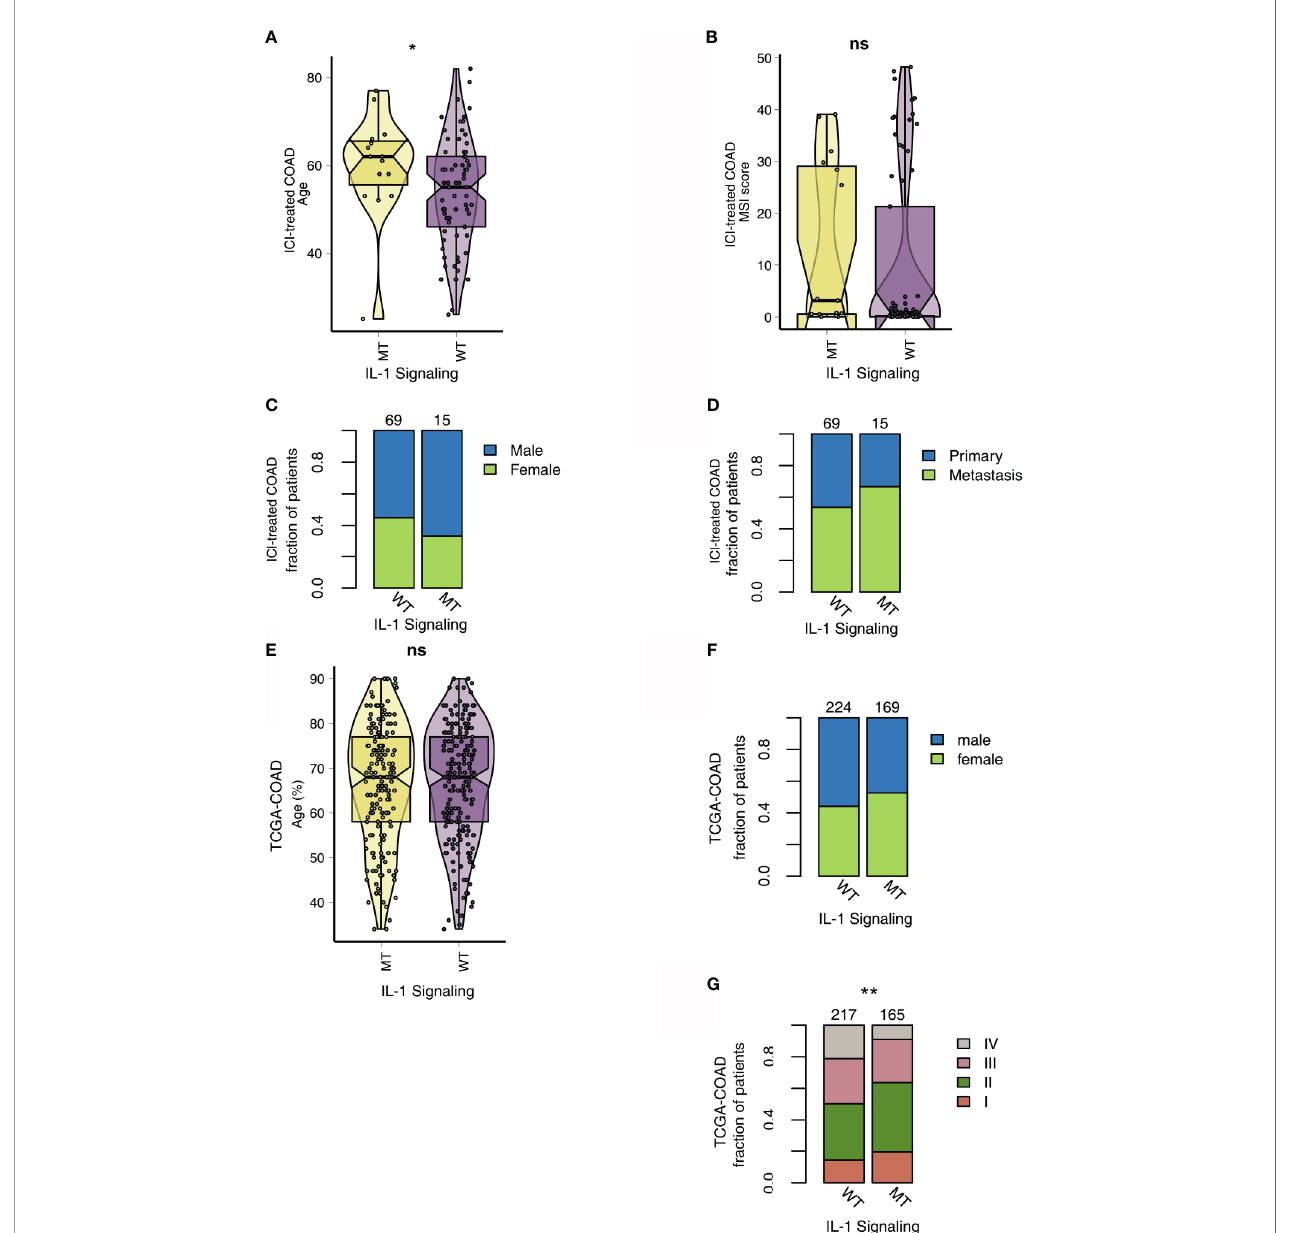
FIGURE 3 | Comparison of clinical characteristics between IL-1-MT and IL-1-WT tumors. (A) Comparison of age between IL-1-MT and IL-1-WT tumors in the ICI-treated COAD cohort. (B) Comparison of the MSI score between IL-1-MT and IL-1-WT tumors in the ICI-treated COAD cohort. (C) Comparison of the sex proportions between IL-1-MT and IL-1-WT tumors in the ICI-treated COAD cohort. (D) Comparison of the sample type proportions between IL-1-MT and IL-1-WT tumors in the ICI-treated COAD cohort. (E) Comparison of age between IL-1-MT and IL-1-WT tumors in the TCGA-COAD cohort. (F) Comparison of the sex proportions between IL-1-MT and IL-1-WT tumors in the TCGA-COAD cohort. (G) Correlation analysis of the clinical stage proportions between IL-1-MT and IL-1- WT tumors in the TCGA-COAD cohort. (*P < 0.05; **P < 0.01; ns, not signi fi